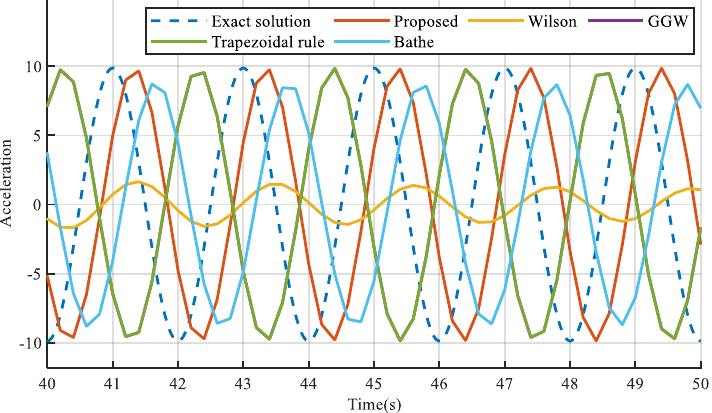
Figure 6. Velocity responses with the Wilson method, Bathe method, GGW method, trapezoidal rule, and the proposed method from 40 to 50 s.